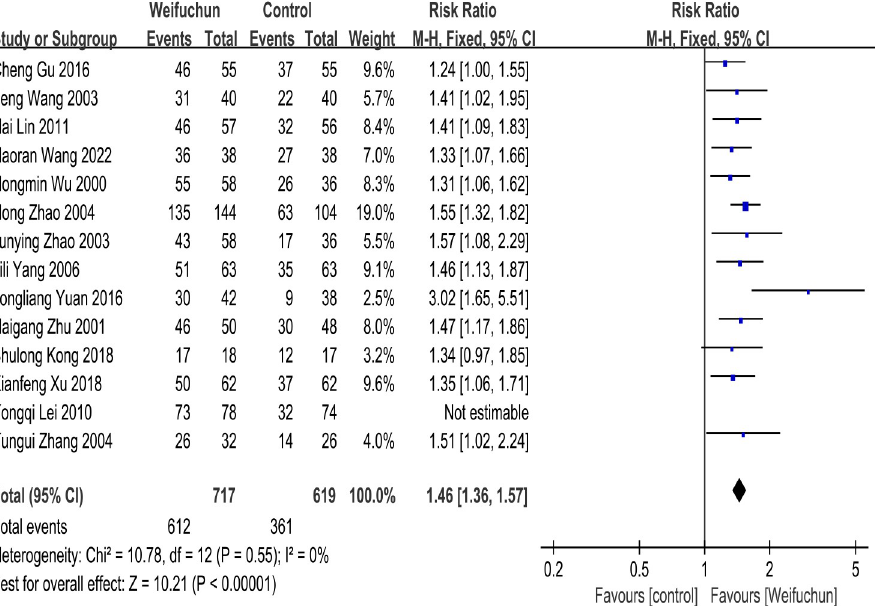
Fig 4. Forest plot of sensitivity analysis of clinical